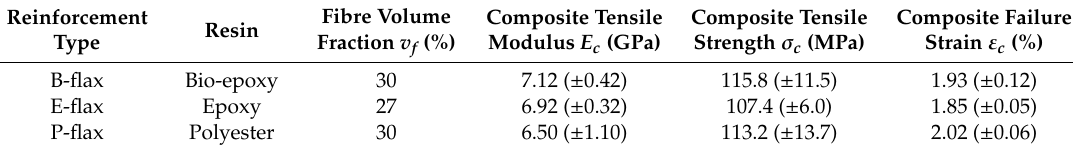
Table 3. Tensile properties of flax fiber composites (mean ± stdev).